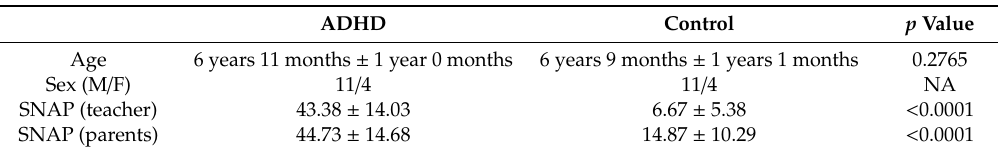
Table 1. Demographic data of the patients with attention-deficit hyperactivity disorder (ADHD) and controls.